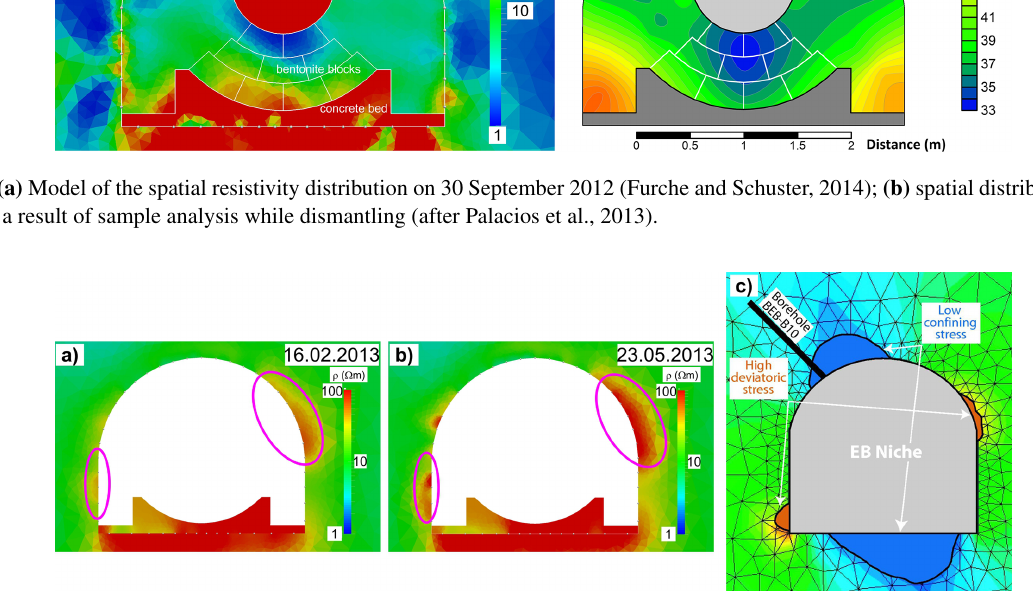
Figure 7. (a, b) Resistivity distribution in the Opalinus Clay around the EB niche at two distinct time steps after finishing the dismantling (after Furche and Schuster, 2014) 16 February and 23 May 2013; (c) spatial stress distribution in the environment of the EB niche (after Corkum,